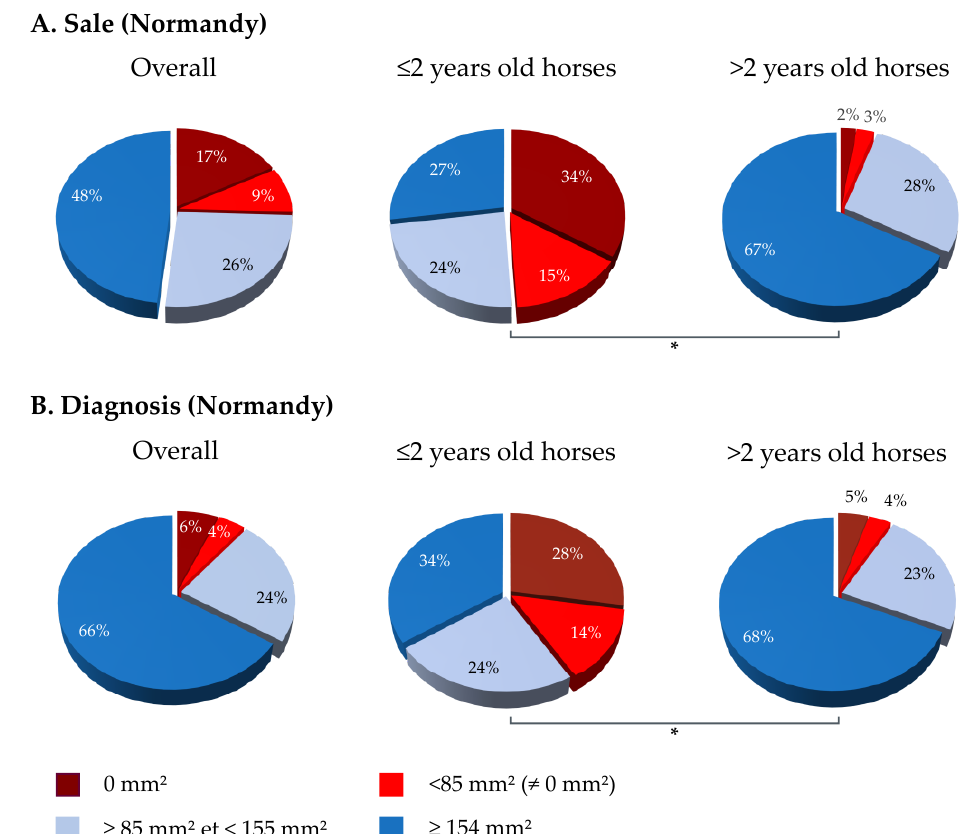
Figure 3. Analysis of “Sale” and “Diagnosis” categories in Normandy. SRH antibody response in ≤ 2 and > 2 years old horses at the time of sample collection (horses born in 2016 and 2017). ( A ) Sale category and ( B ) Diagnosis category. (*) p -value ≤ 0.00001.